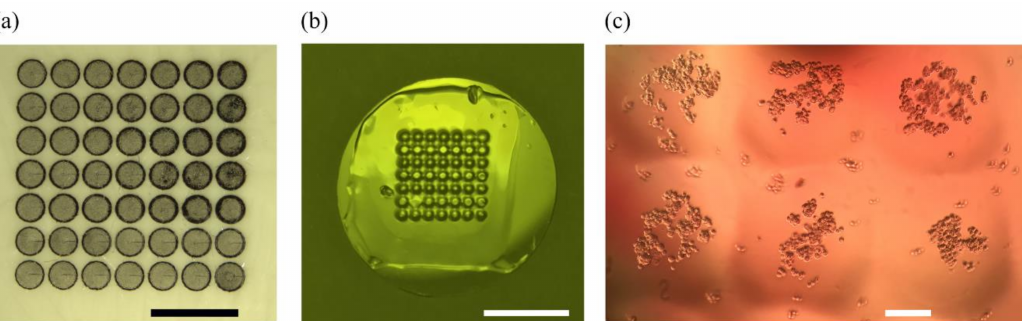
Figure 9. Polyacrylamide hydrogels with microposts structures: PMMA laser-etched mold with microwells ( a ), vertical microposts are transferred to polyacrylamide ( b ) and A549 cells were seeded on 300 micron wide hydrogel pillars for confinement studies ( c ). Scale bars are 3 mm for ( a ), 1 cm for ( b ), and 100 µ m for ( c